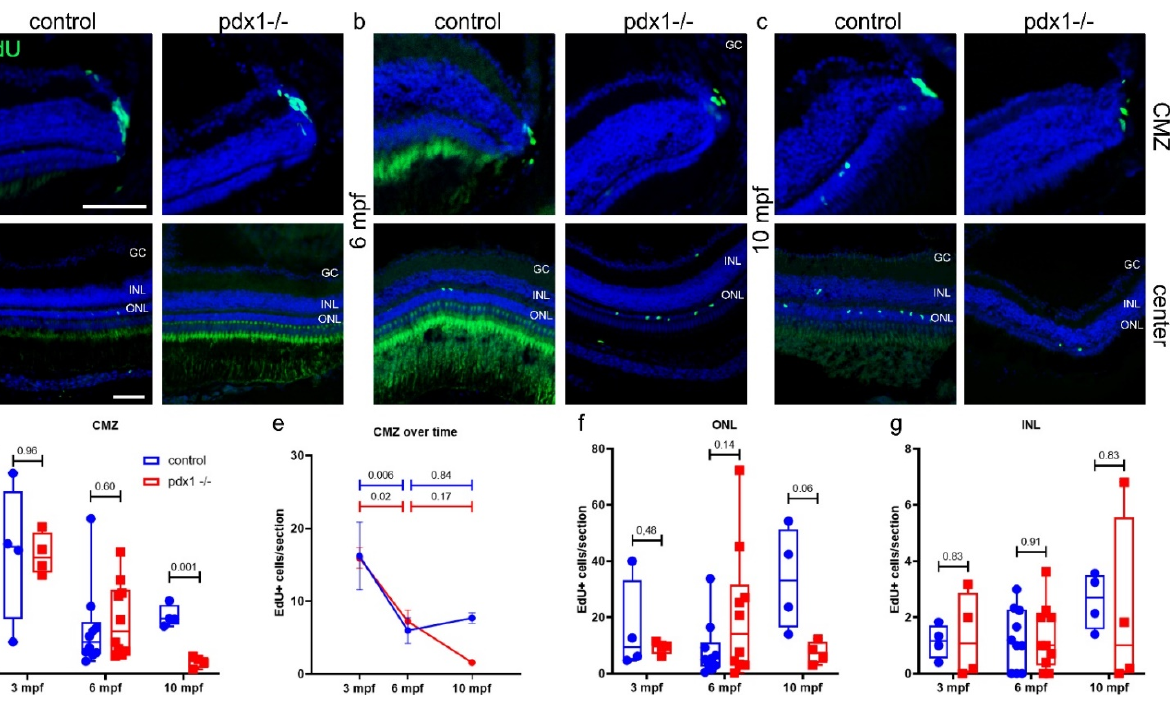
Figure 4. Chronic hyperglycemia impacts proliferation in progenitor populations. Cryosections of control and pdx1 − / − retinas at 3 mpf ( a ), 6 mpf ( b ) and 10 mpf ( c ). Cryosections were stained for EdU to identify cells that underwent proliferation (green) and counterstained with DAPI (blue). ( d , e ) Quantification of EdU positive cells in the ciliary marginal zone (CMZ) depicted in a box plot ( d ) and the same data shown as a line plot over time ( e ). Quantification of EdU positive cells in the ONL ( f ) and the INL ( g ) at 3, 6 and 10 mpf. Box plot extends from 75% to 25%, showing all data points, line indicates median. n = 4–10 fish per time point. Scale bar: 50 μ m. (GC, ganglion cell layer; INL, inner nuclear layer; ONL, outer nuclear layer).